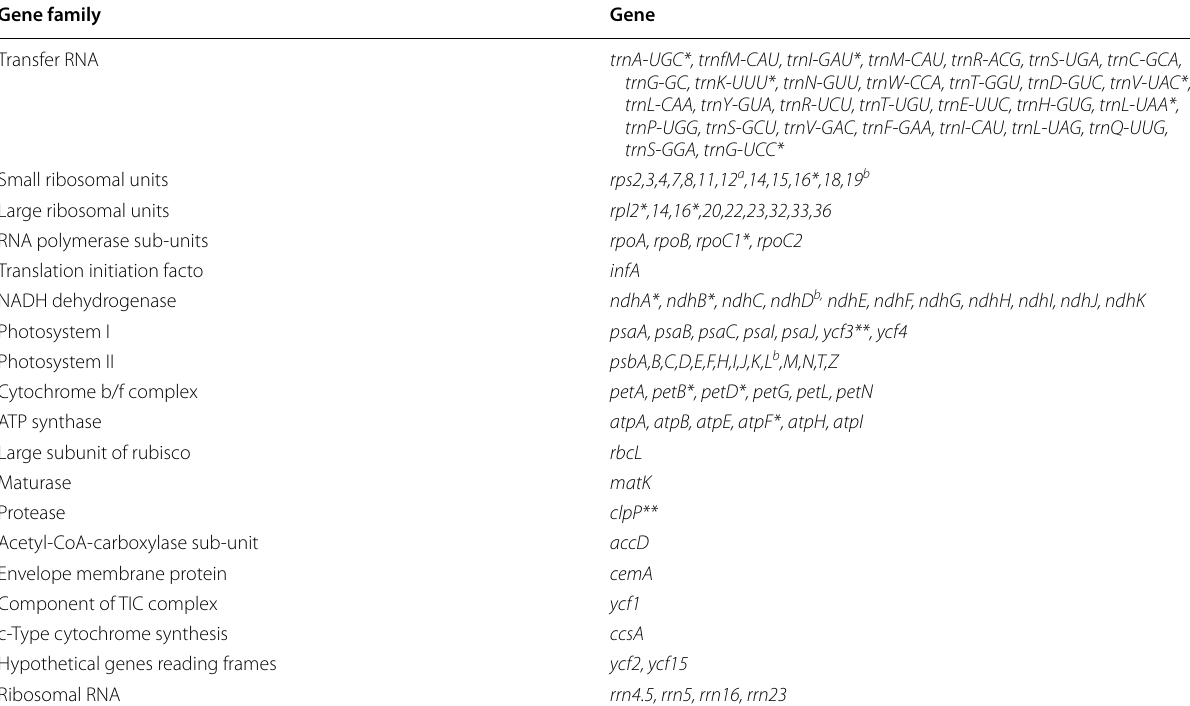
* Genes with a single intron, ** genes with two introns, a trans-spliced genes, b genes with an alternative start codon